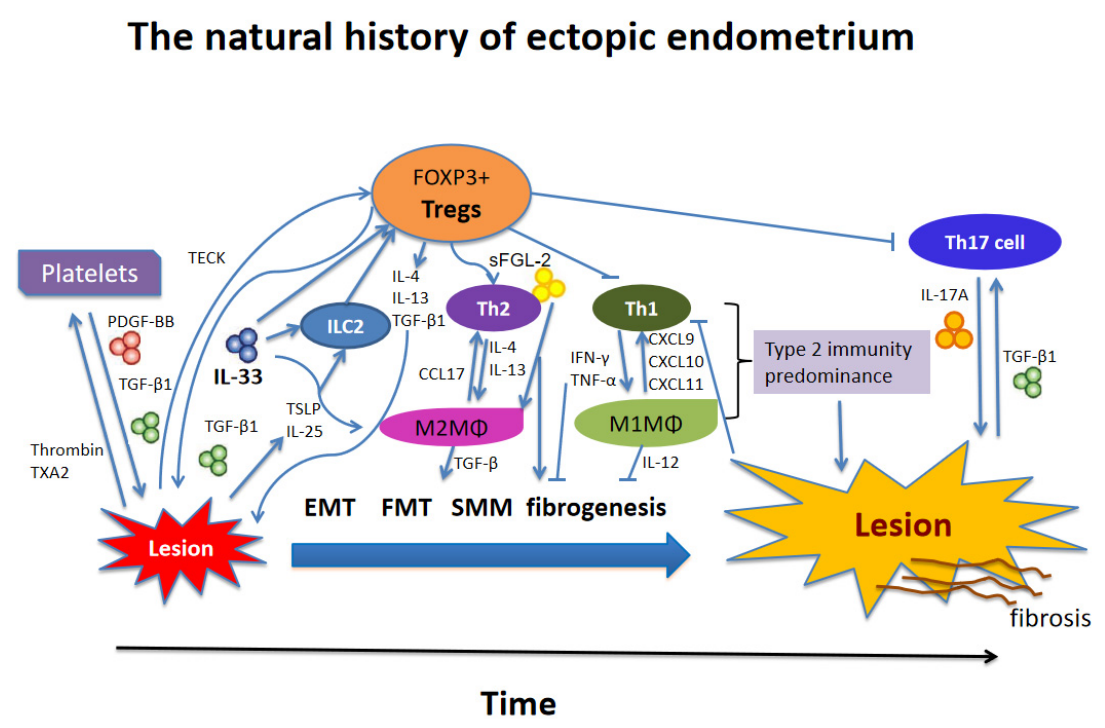
Figure 6. Schematic summary of the local immune environment during the progression of endometriosis.Tissue injury results in the release of alarmins such as IL-25, IL-33, and TSLP, which, individually or collectively, promote a type 2 immune response in endometriotic lesions. In particular, platelets and Tregs together promote a type 2 immunity predominance, which is exemplified by the recruitment and aggregation of Th2 cells, M2 macrophages, and possibly group 2 innate lymphocytes (ILC2s) within the lesional immune microenvironment. These type 2 immune cells subsequently release type 2 cytokines, such as IL-4 and IL-13, which polarize macrophages into alternatively activated M2 macrophages, producing more type 2 cytokines. Lesion-derived IL-33 exacerbates endometriosis through polarizing macrophages to the M2 subtype and promotes Tregs to transform into Th2-like Tregs, producing higher amounts of IL-4, IL-13, and TGF- β 1. M2 macrophages can release copious TGF- β 1 and PDGF, inducing EMT, FMT, SMM, and fibrogenesis. Platelets and Tregs, in and of themselves and also by the induction of type 2 immune response induce the TGF- β 1 and PDGF signaling pathways to promote fibrogenesis of endometriosis. sFGL-2 secreted by Tregs induces M2 macrophages and inhibits Th1 and Th17 cell differentiation while promoting Th2 and Tregs differentiation. See text for more details. IL: interleukin; PDGF-BB: platelet-derived growth factor-BB; ILC2: group 2 innate lymphoid cells; M Φ : macrophage; Tregs: regulatory T cells; Th: T helper cell; TGF- β 1: transforming growth factor β 1; IFN- γ : interferon- γ ;